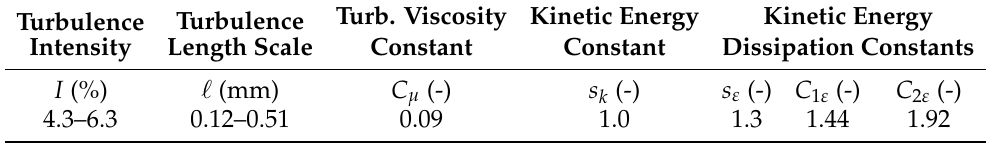
Table 3. Parameters of the k - ε